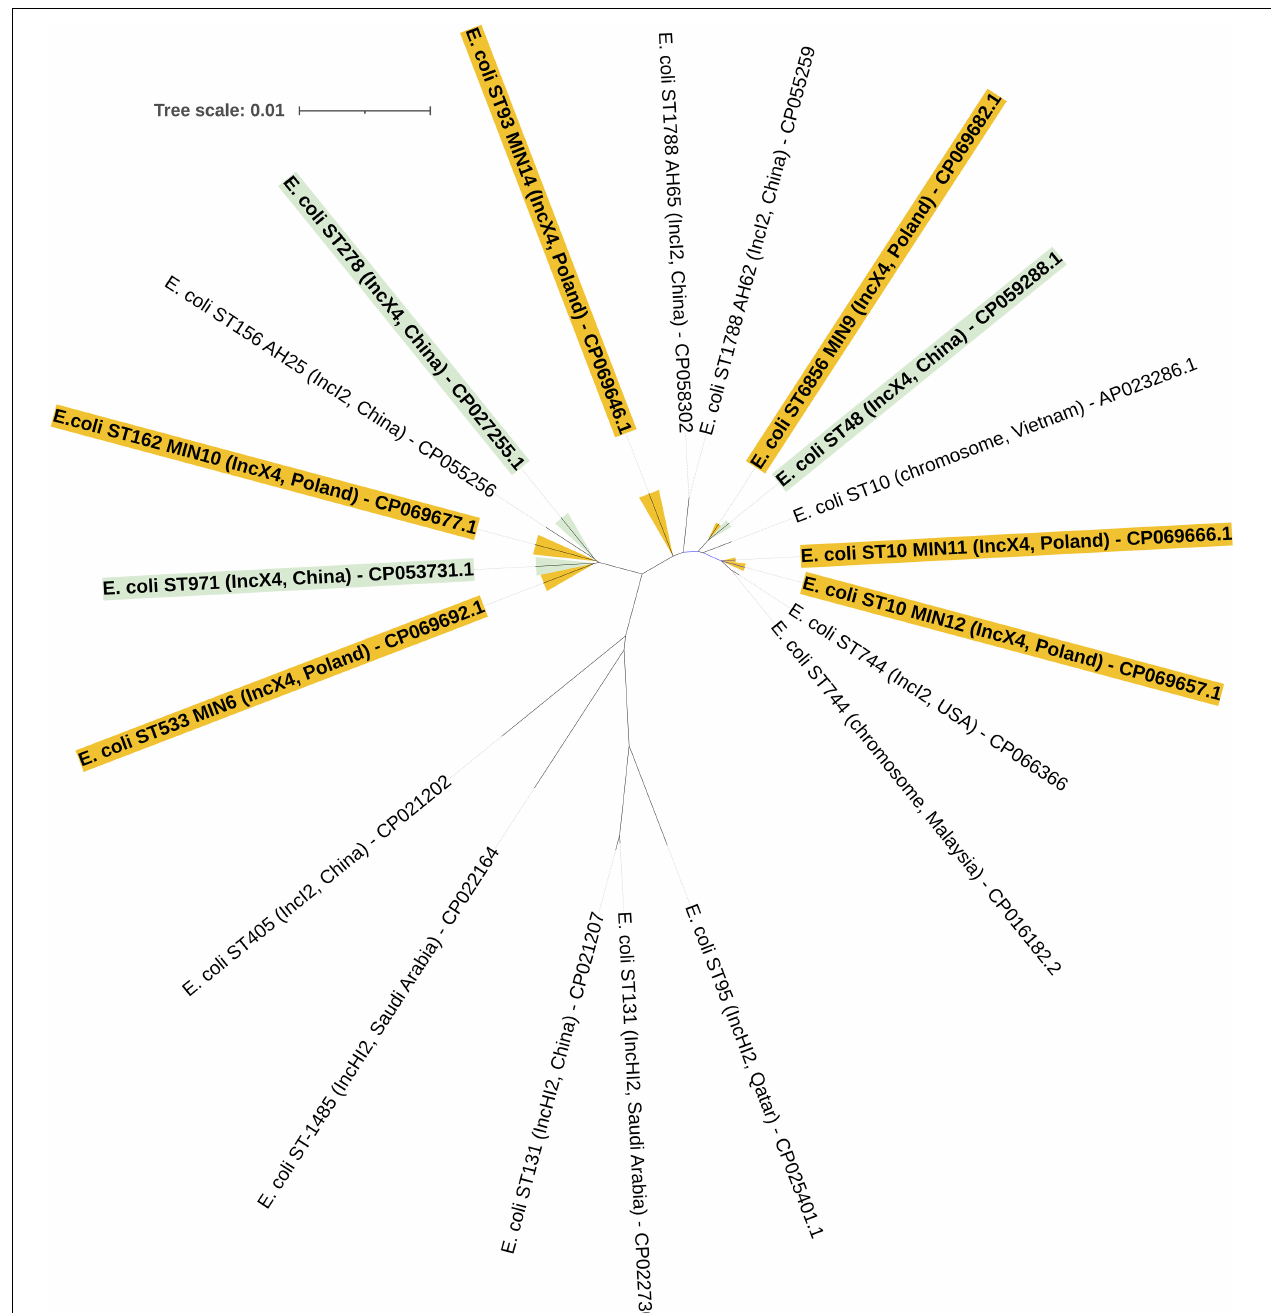
FIGURE 4 | Whole-genome sequence-based GBDP tree of mcr -producing E. coli complete genomes available at NCBI. Tree inferred with FastME 2.1.6.1 [6 (Lefort et al., 2015)] from GBDP distances calculated from genome sequences. The branch lengths are scaled in terms of GBDP distance formula d5.